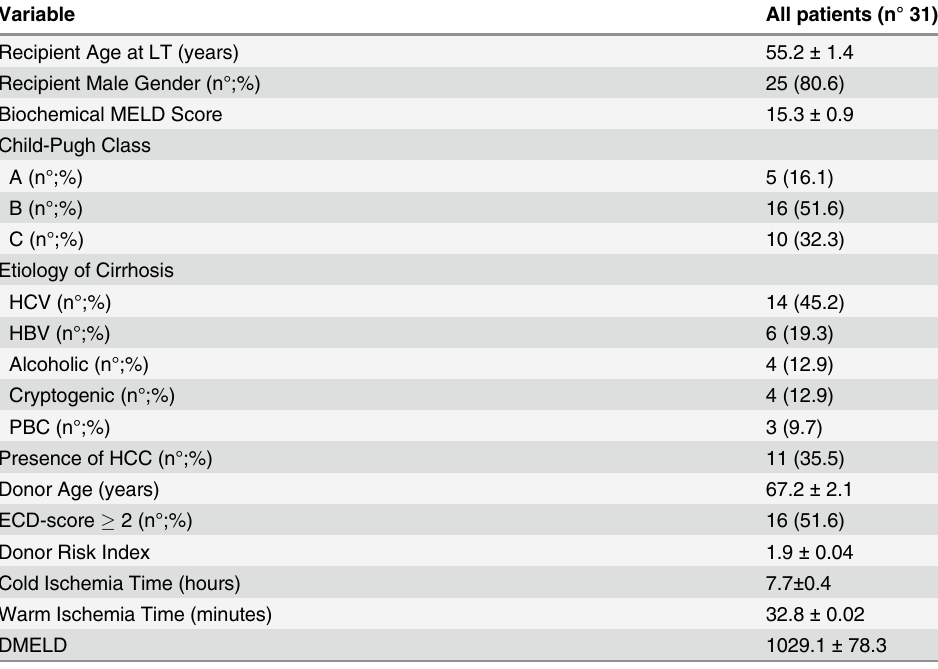
Table 1. Baseline recipients ’ and donors ’ characteristics. Continuous values are expressed as the mean ± standard error of the mean. LT, liver transplantation; MELD, Model for End-Stage Liver Disease; PBC, primary biliary cirrhosis; ECD, extended criteria donor; DMELD, donor age x recipient